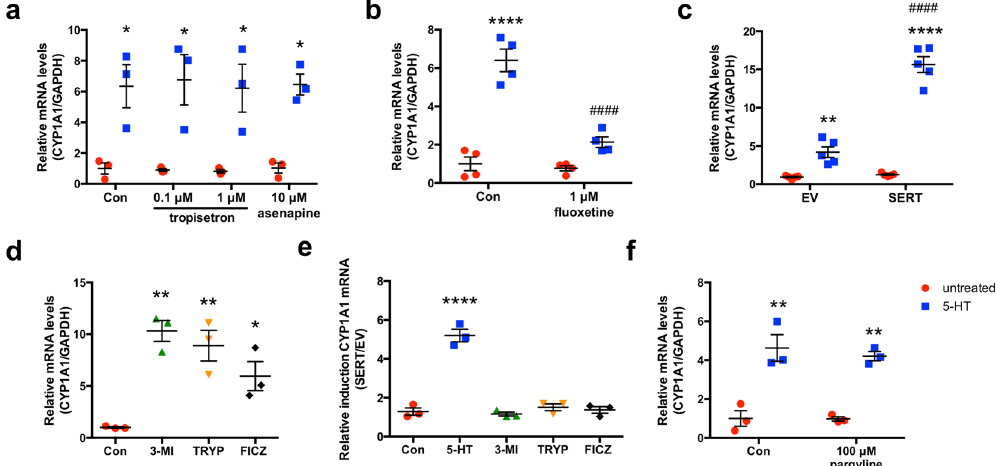
Figure 2. Induction of CYP1A1 mRNA is independent of 5-HTRs and MAOs but is dependent upon SERT. Caco-2 cells were plated at low density and allowed to differentiate for 10–14 d in medium containing 20% serum before treatments were performed without transfection ( a , b , f ). When transfection was performed, Caco-2 cells were treated beginning 24 h post-transfection ( c – e) . ( a ) Caco-2 cells were treated with vehicle (Con) or 5-HTR antagonists tropisetron or asenapine apically for 1 h before co-treatment with 5-HT for 8 h in serum-free medium ( n = 3). ( b ) Caco-2 cells were treated with vehicle (Con) or fluoxetine (1 μ M) for 4 d in serum-containing medium before co-treatment of 5-HT (10 μ M) with fluoxetine (1 μ M) for 12 h in serum-free medium ( n = 4). ( c ) Caco-2 cells were transiently transfected with SERT overexpression plasmid or empty vector (EV) by Amaxa electroporation before treatment with 5-HT (10 μ M) for 24 h ( n = 5). ( d , e ) Caco-2 cells were transfected with EV or SERT by Amaxa electroporation before treatment with vehicle (Con) or AhR ligands 3-methylindole (3-MI, 100 μ M), tryptamine (TRYP, 100 μ M), or 6-formylindolo[3,2 b ]carbazole (FICZ, 10 nM) for 24 h in serum-free medium. ( d ) depicts CYP1A1 expression when transfected with EV while ( e ) depicts the ratio of CYP1A1 induction between SERT and EV transfected cells, with no difference observed for any treatments other than 5-HT ( n = 3). ( f ) Caco-2 cells were treated with vehicle (Con) or MAO inhibitor pargyline for 1 h before co-treatment with 5-HT for 8 h in serum-free medium ( n = 3). Data represent the relative expression of CYP1A1 mRNA quantified by qPCR. Data analyzed by 1-way ( a – c , f ) or 2-way ( d , e ) ANOVA followed by Tukey’s ( a – c , f ) or Bonferroni’s ( d , e ) multiple comparisons test. * P < 0.05, ** P < 0.01, **** P < 0.0001 vs. untreated. ### P < 0.001 vs. no fluoxetine or EV. Red circle = untreated, blue square = 5-HT, green triangle = 3-MI, yellow triangle = TRYP treated, black diamond =